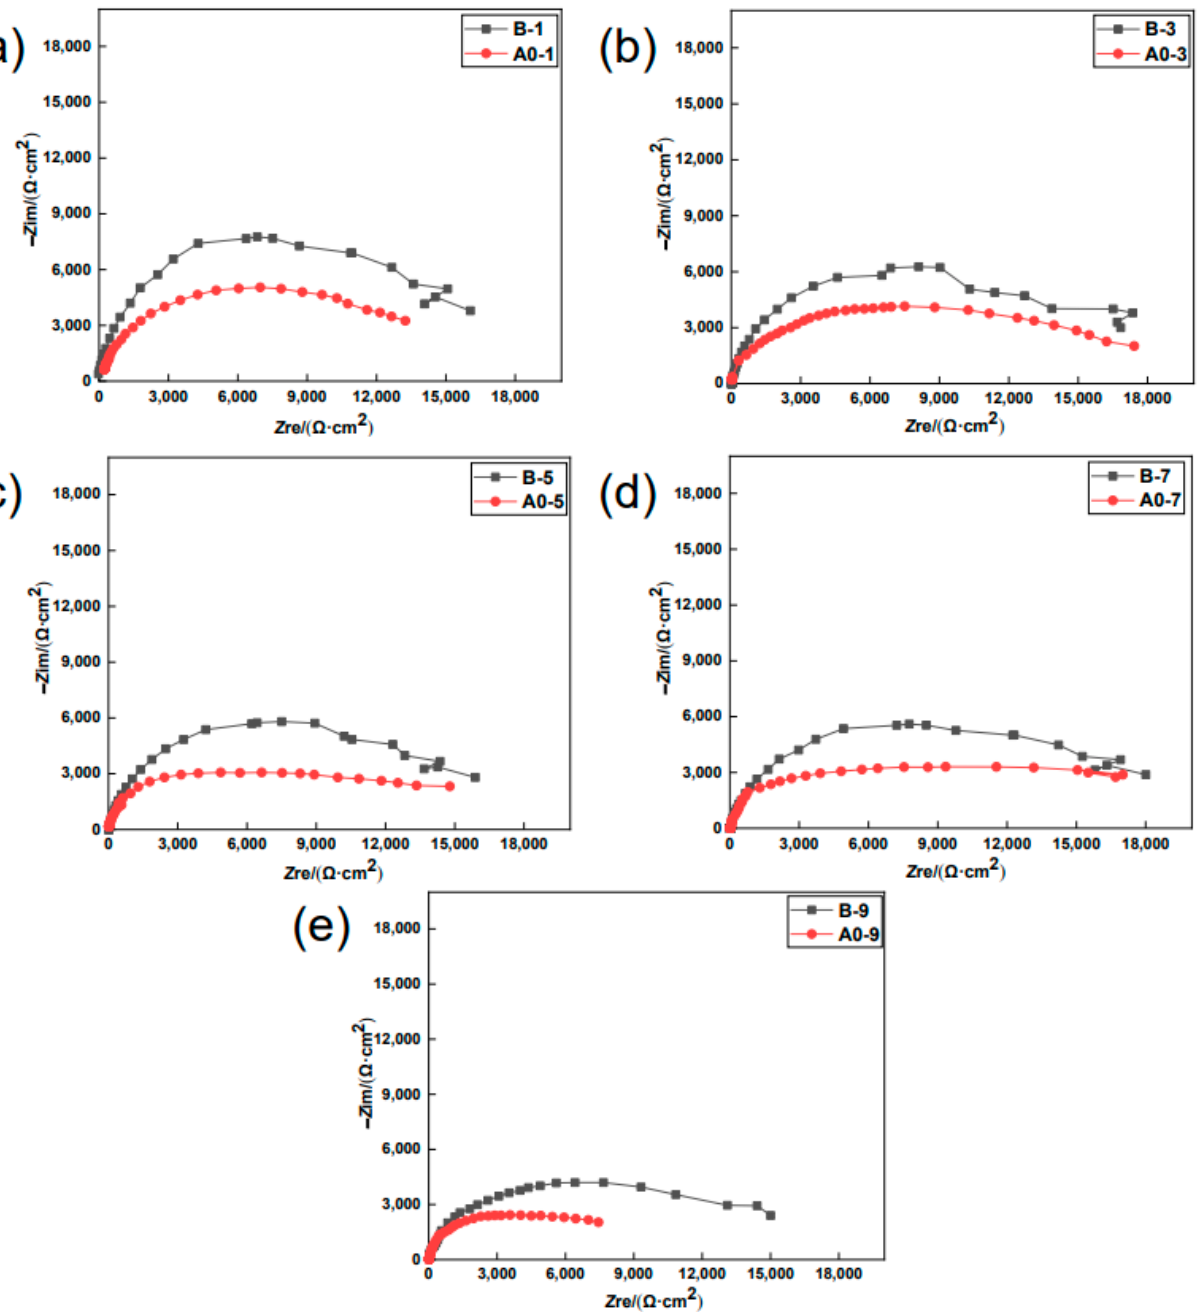
Figure 2. Nyquist plot of B versus A0 at different degrees of chloride erosion (where 1, 3, 5, 7, and 9 represent the specimens coated with MCIs after the 1st ( a ), 3rd ( b ), 5th ( c ), 7th ( d ), and 9th ( e ) drying-wetting cycles, respectively).